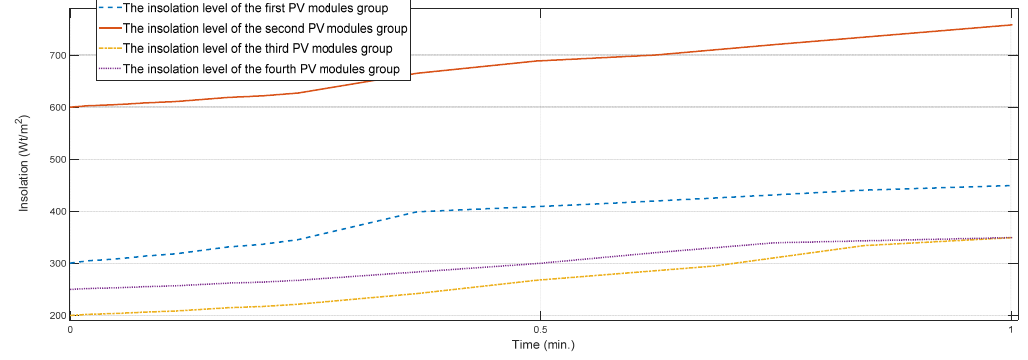
Figure 5. The dynamics of PV array insolation levels.